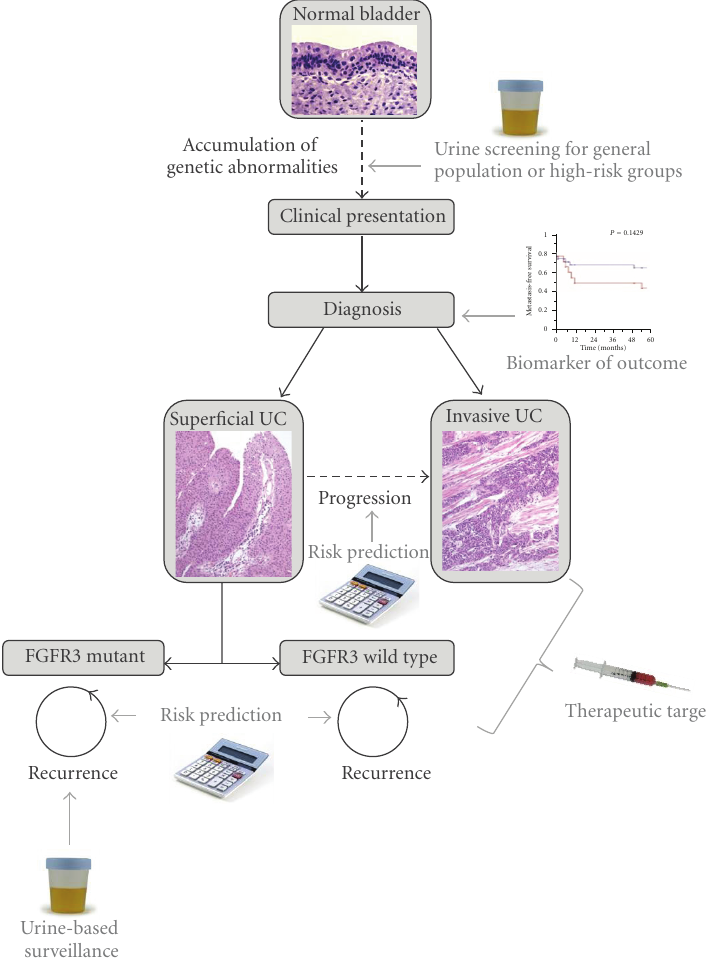
Figure 3: Potential applications of FGFRs in the early detection and clinical management of bladder